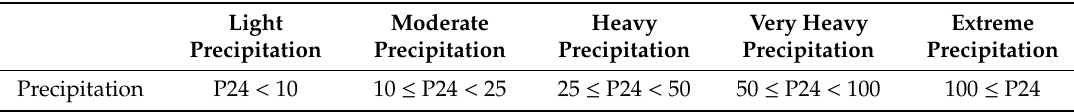
Table 1. Grade of precipitation [31] (unit: mm).